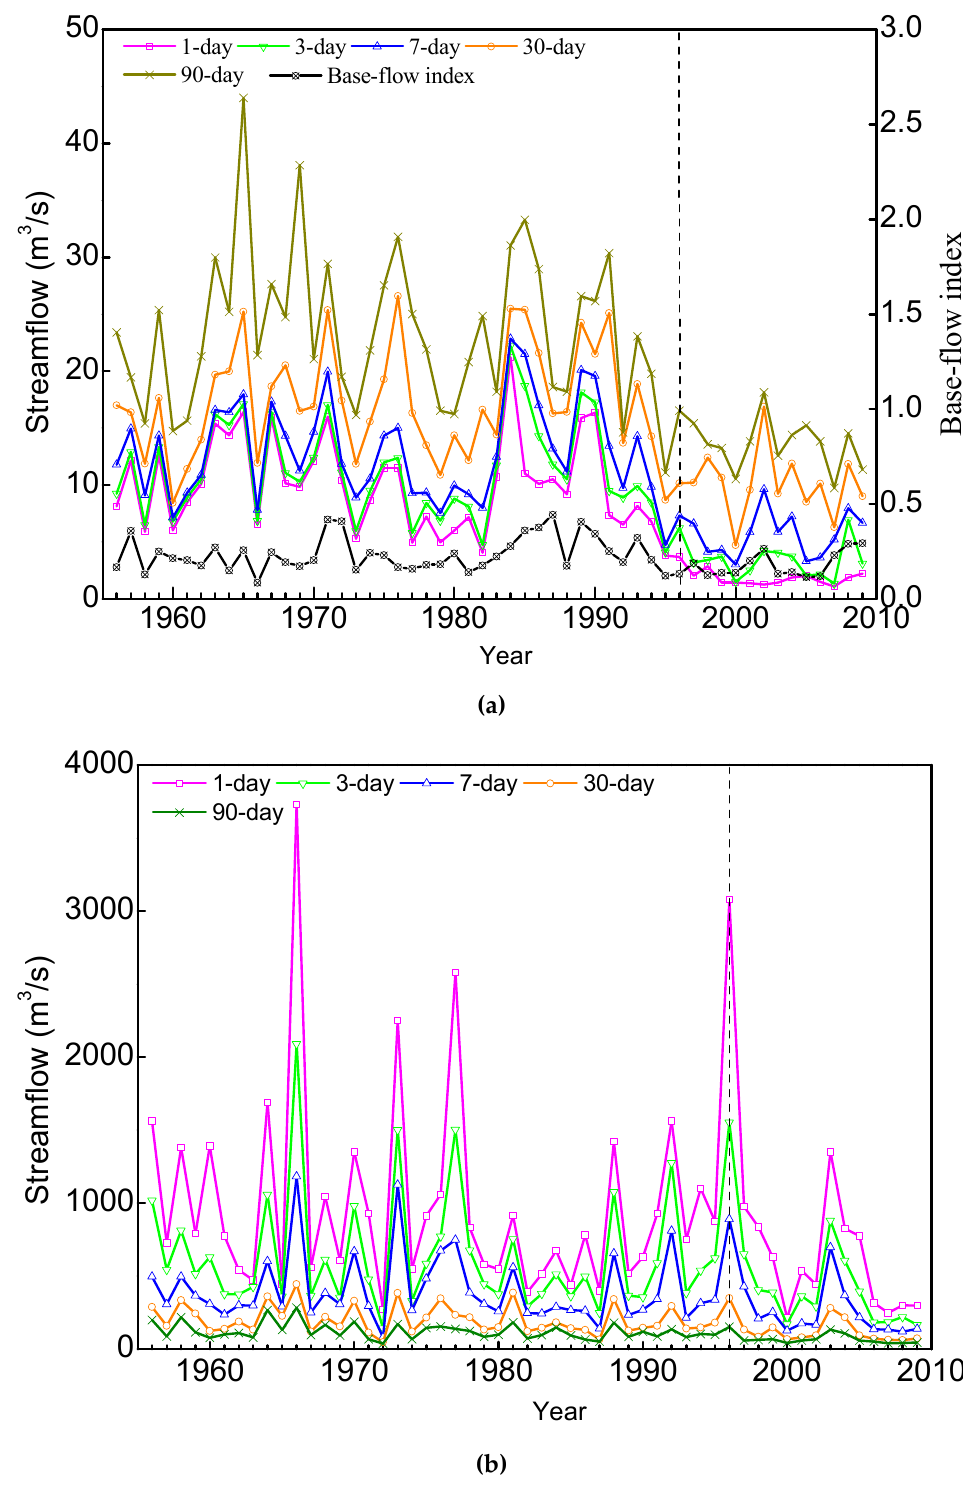
Figure 4. Changes in the magnitude of ( a ) annual minimum flow and ( b ) annual maximum flow with different durations at Zhangjiashan Station (the outlet of the Jinghe Basin).